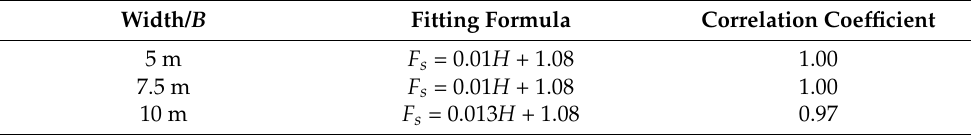
Table 3. Fitting formula between the stability factor and ELB